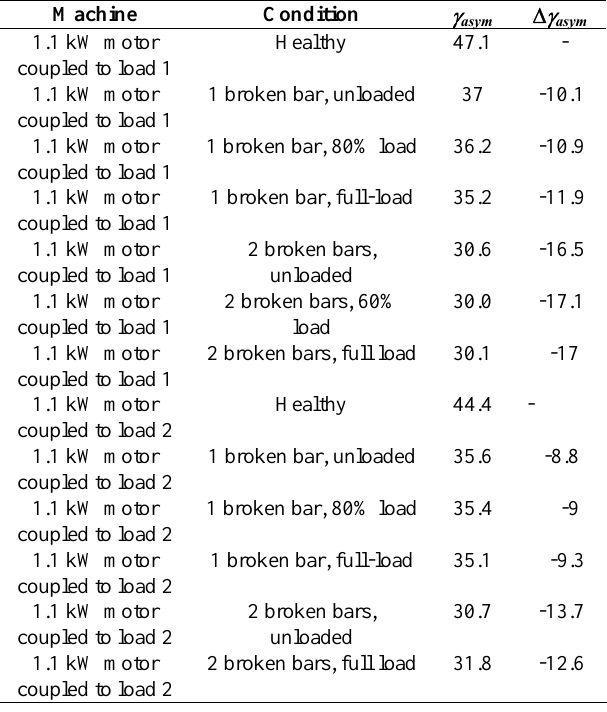
Table 1. Computation of the indicator γ asym for each case tested and deviation with respect the healthy condition ( ∆γ asym